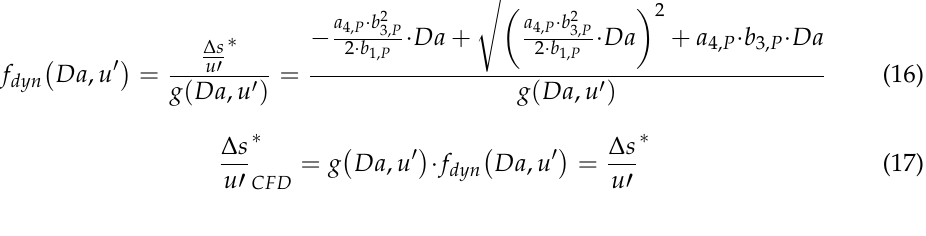
Figure 8. Flame speed ratio 𝑠 𝑇 𝑠 𝐿 ⁄ as a function of 𝑢′ 𝑠 𝐿 ⁄ for ECFM-3Z (Model 1): reference exp. values from Peters [1] ( 𝑠 𝑇 𝑠 𝐿∗ ⁄ , black), original ECFM-3Z results ( 𝑠 𝑇 𝑠 𝐿,𝐶𝐹𝐷 ⁄ , red), and dynamic ECFM-3Z results ( 𝑠 𝑇 𝑠 𝐿,𝐶𝐹𝐷∗ ⁄ , green). Results for Da = 0.5 – 1 – 1.5 ( a ), Da = 5 – 10 – 18 ( b ), and Da = 37 – 57 – 75 ( c ).